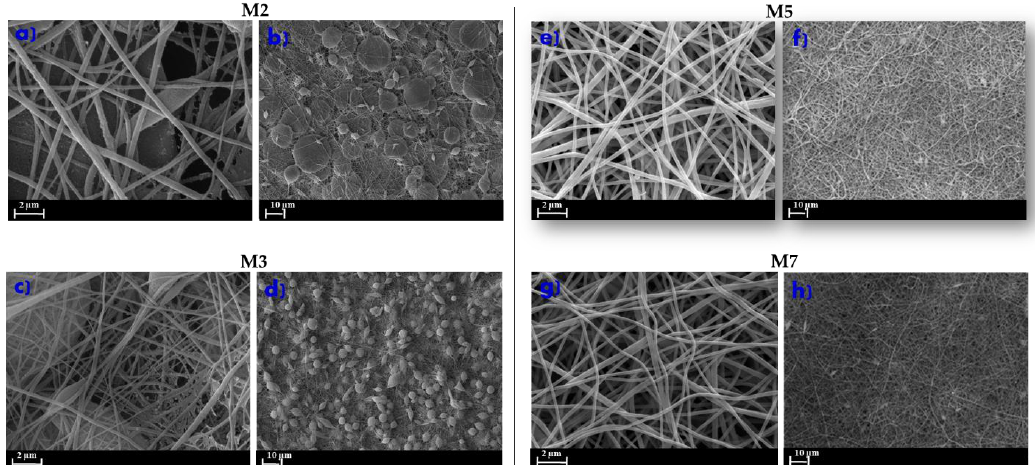
Figure 3 . SEM pictures of the ENMs using dimethyl sulfoxide (DMSO)/acetone as a mixture of solvents at different post-treatments with and without LiCl. M2 ( a ) and ( b ); M3 ( c ) and ( d ); M5 ( e )